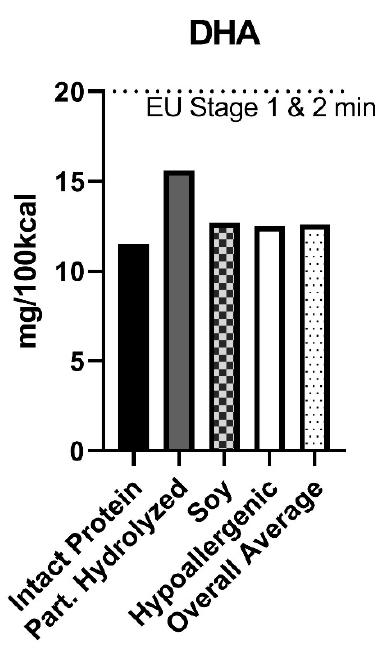
Figure 3. DHA content of infant formula purchased in the US between 2017–2019. Powdered infant formula purchased from all major physical retailers (excluding Costco) in the US between 2017–2019. The average docosahexaenoic acid (DHA) content (mg/100 kcal), controlling for volume purchased, is reported in each category of formula. The horizontal line represents the European Union (EU) minimum required concentration for both Stage 1 and 2 formulas. DHA is not a required ingredient in US formulas.